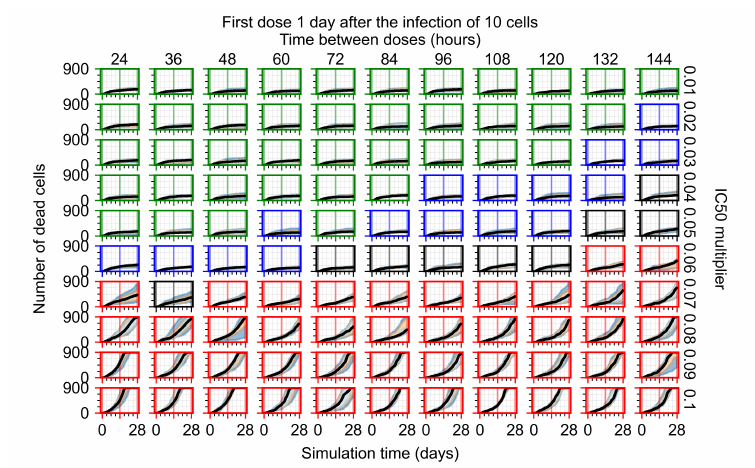
Figure A24. Dead population.